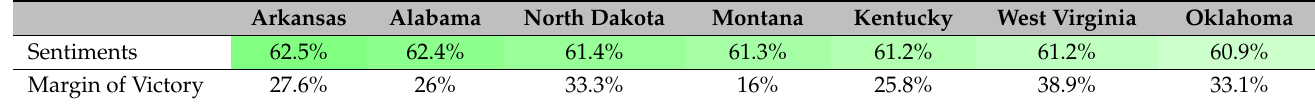
Table 6. Trump: extreme positive sentiment states.